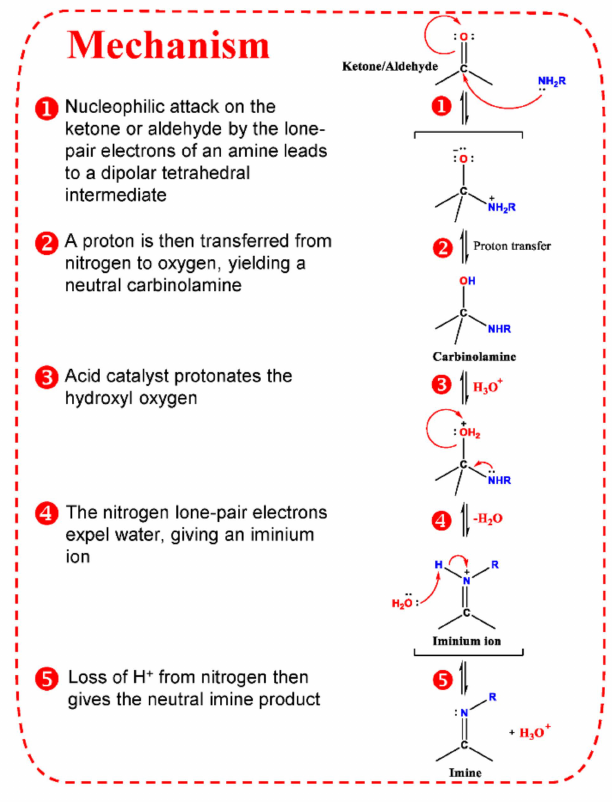
Figure 3. Mechanism of imine